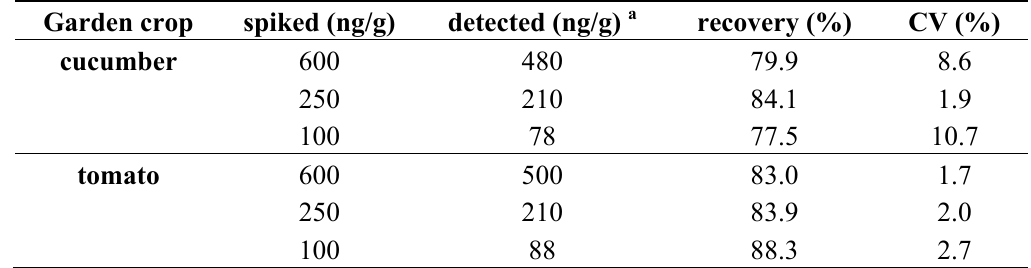
Table 3. Recovery rates of clothianidin spiked into garden crops in the HPLC analysis. Garden